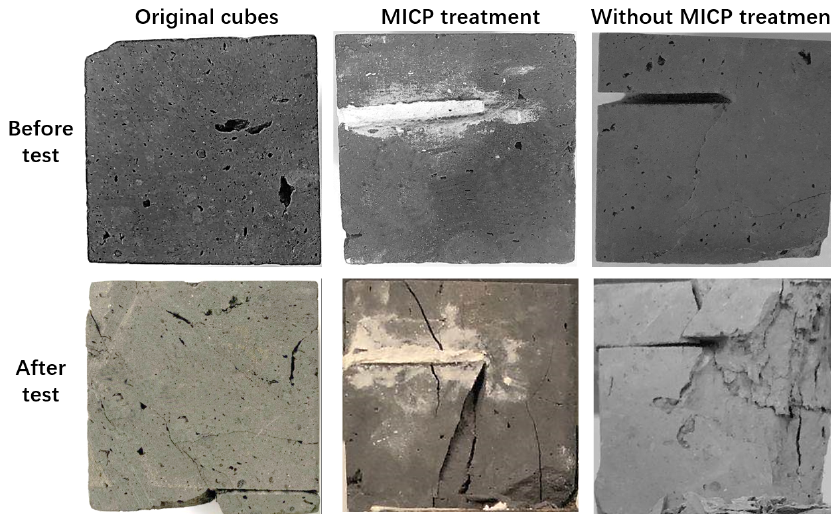
Figure 2. Close-up of the brick cubes after 7 days from MICP remediation. ( A ) Brick cubes with natural cracks; ( B ) brick cubes with simulated cracks.